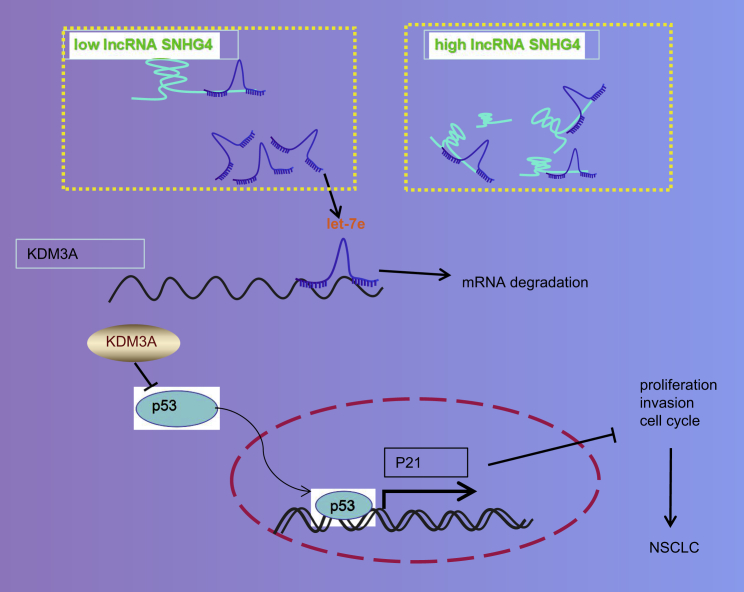
Systematic diagram showing how the lncRNA SNHG4/let-7e/KDM3A/p21 pathway is involved in the development of NSCLClncRNA SNHG4 binds with miR-let-7e and thus positively regulates the expression of KDM3A. KDM3A, a histone demethylase, inhibits the transcriptional activity of p53 by erasing p53-k372me1 and reduces the expression of p21. In this context, reduced p21 promotes the development of NSCLC.